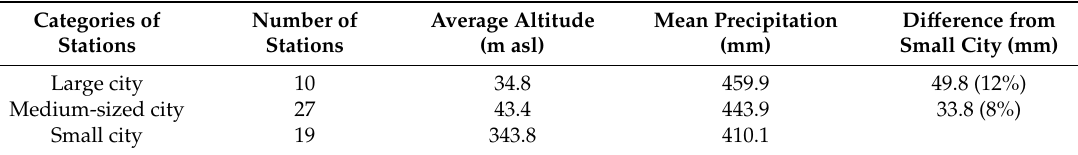
Table 1. The average altitudes and warm-season mean precipitation of the city stations in the Haihe River basin, 2007–2017.